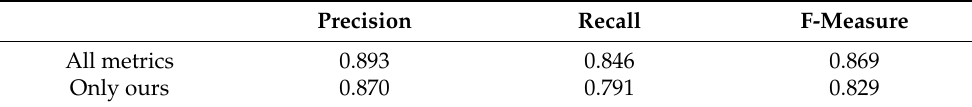
Table 5. General results (Precision, Recall, F-measure) we receive for face recognition, using all metrics and only our ones.